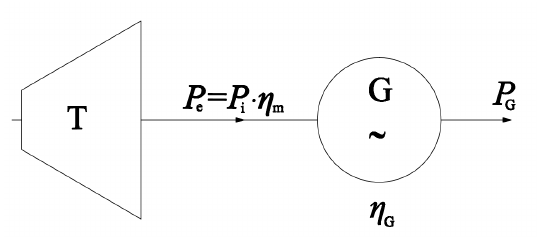
Figure 5. Turbine genset for electricity production during ship sails.